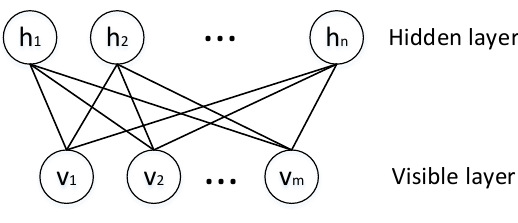
Figure 4. The structure of the RBM.